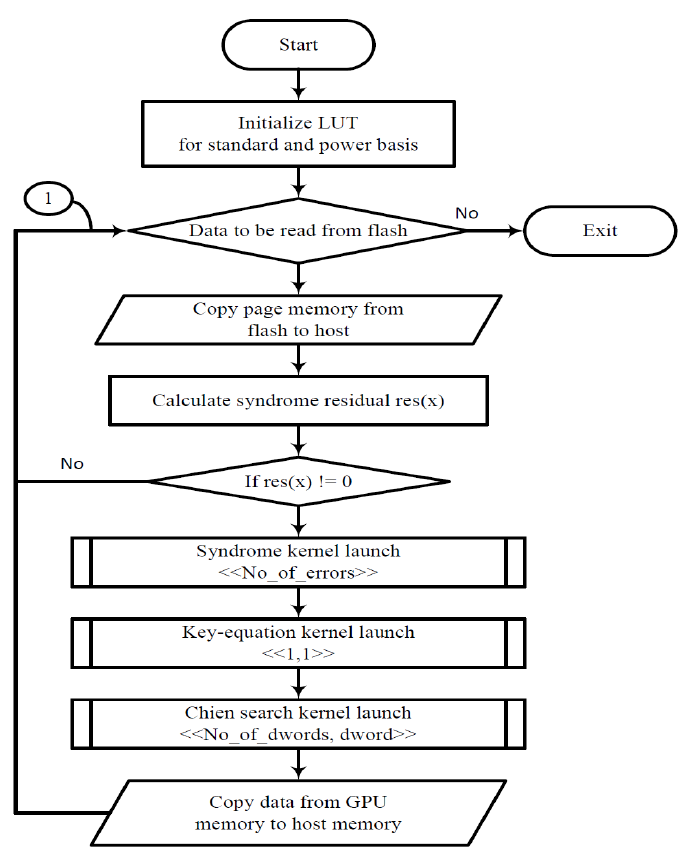
Figure 3. Flow chart for the hybrid